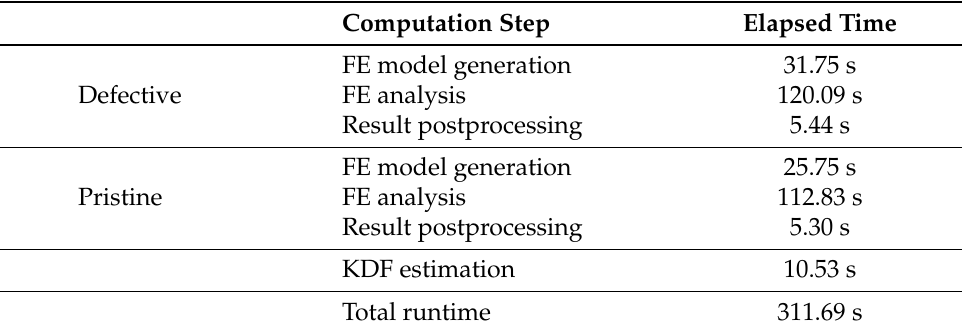
Table 2. Computation